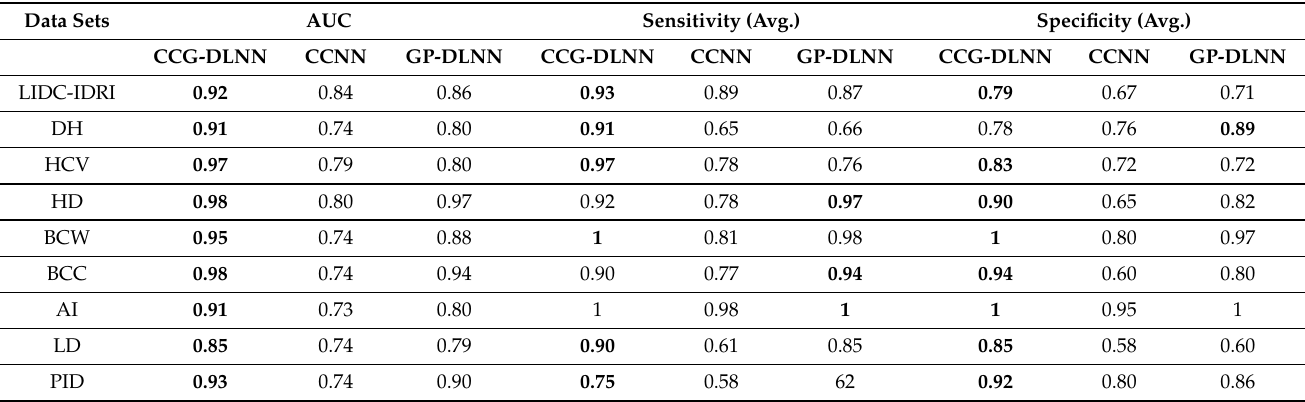
Table 6. Classification performance summary.